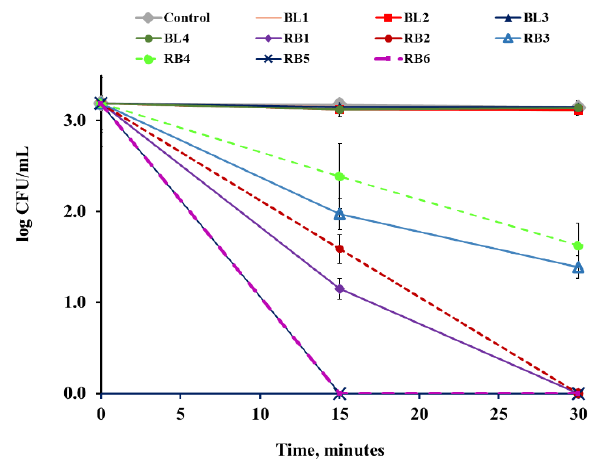
Figure 6. Activity of BL1–BL4 and RB1–RB6 against E. coli under illumination with a white luminescent lamp at a fluence rate of 39.5 mW cm −2 at 25 °C. Control—untreated bacterial cells.